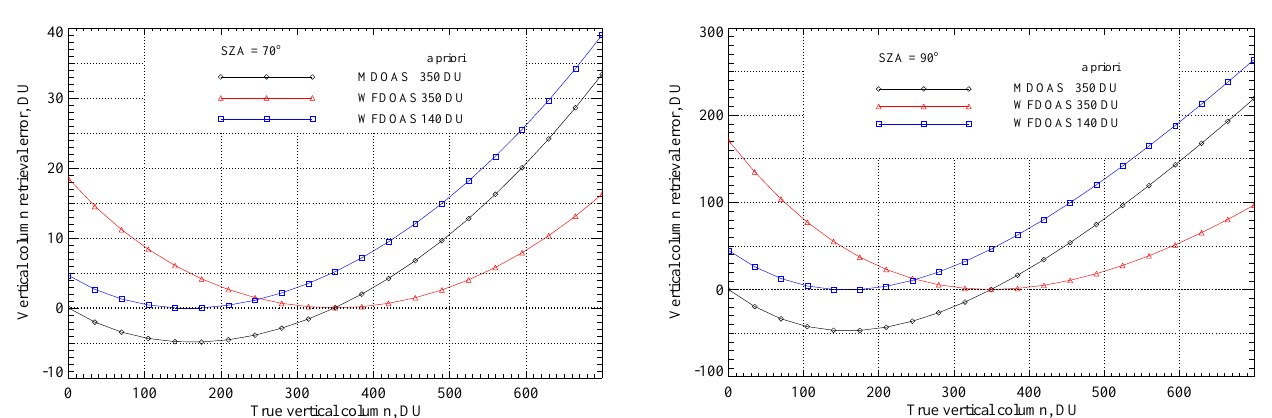
Fig. 4. Error in the retrieved vertical column of ozone as a function of the true vertical column for a solar zenith angle of 70 ◦ . The re- sults of MDOAS and WFDOAS retrievals for a priori vertical col- umn of 350DU are shown with black and red lines, respectively, whereas the errors resulting from WFDOAS equation for a priori vertical column of 140DU are shown with the blue line.